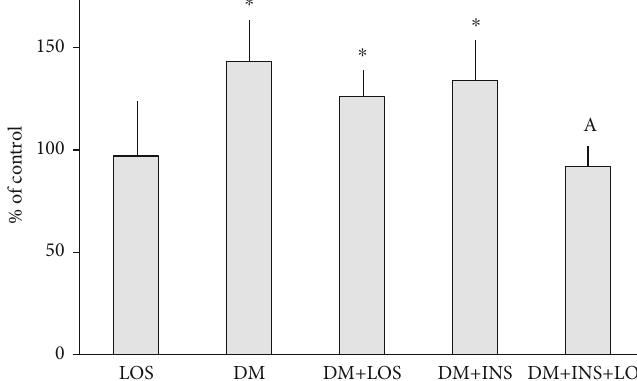
Figure 2: The e ff ect of losartan on a hippocampal increase of KYNA in diabetic rats. Values are arithmetic means ± SD ; ∗∗ p < 0 : 01 vs. CTR; a p < 0 : 05 vs. respective DM (ANOVA with the adjustment of p value by the Bonferroni method). CTR: nondiabetic, healthy rats receiving vehicle; LOS: nondiabetic rats receiving losartan; DM: animals with streptozotocin- (STZ-) induced diabetes; DM+LOS: diabetic animals treated with losartan for 28 days; DM+INS: diabetic animals treated with insulin for 28 days; DM+INS+LOS: diabetic animals treated with insulin and losartan for 28